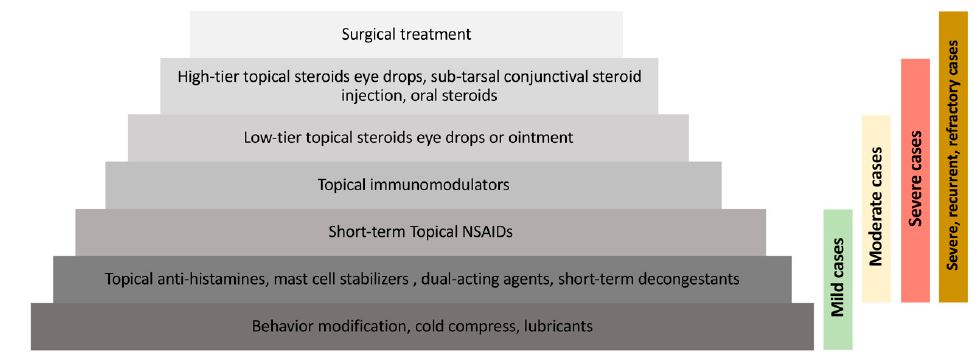
Figure 2. Overview of a stepwise approach to the treatment of allergic conjunctivitis.